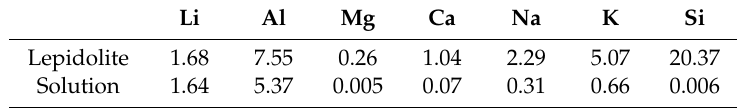
Table 6. The mass fraction (%) of each element in lepidolite powder and leaching solution. Li Al Mg Ca Na K Si Lepidolite